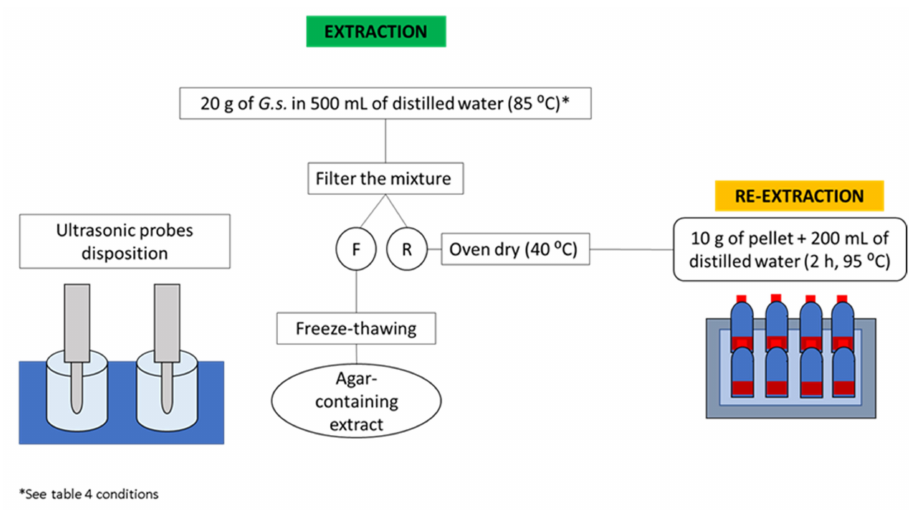
Figure 2. Workflow of the ultrasound-assisted extraction performed for agar extraction (F: filtrate, and R: seaweed